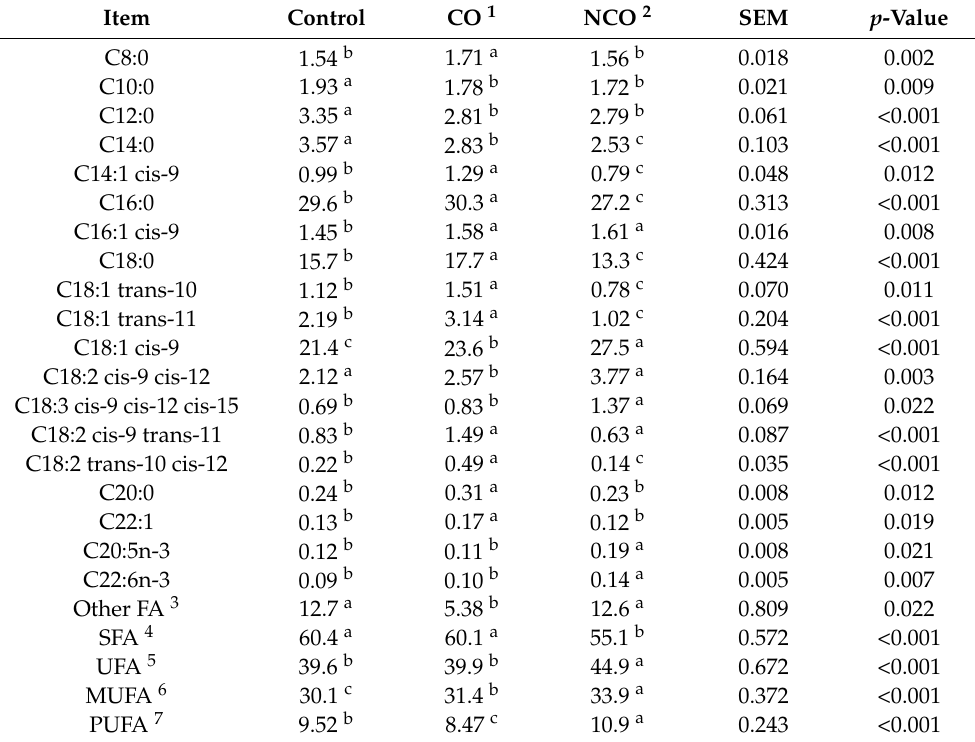
Table 6. The effect of the supplementation of raw and nanoemulsified corn oil on the fatty acid composition in the milk of dairy